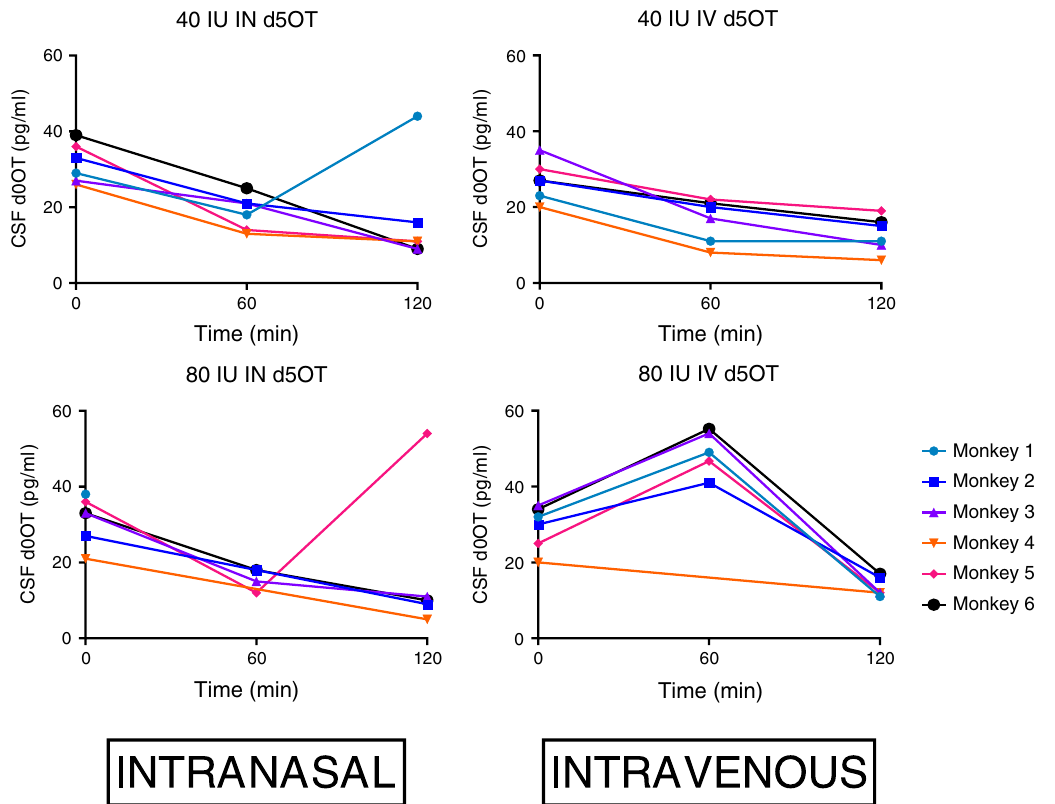
Fig. 3 Cerebrospinal fl uid (CSF) endogenous (d0) oxytocin (OT) concentrations: time course of d0OT in monkey cerebrospinal fl uid (CSF) at baseline (Time = 0) and after intranasal (IN) d5OT 80 and 40 IU; after intravenous (IV) d5OT 80 and 40 IU. Limit of quanti fi cation = 10